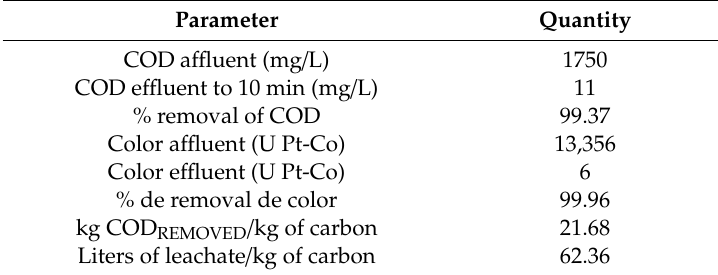
Table 5. Design parameters for the adsorption